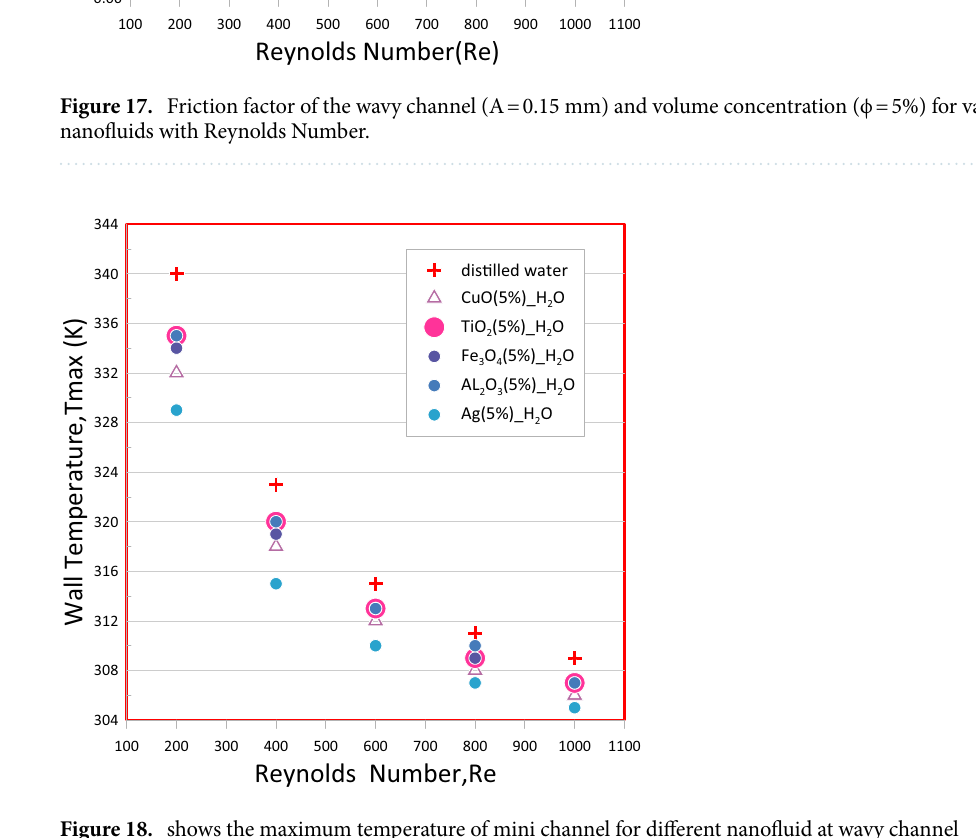
Figure 18. shows the maximum temperature of mini channel for different nanofluid at wavy channel (A = 0.15 mm) for the different Reynolds number